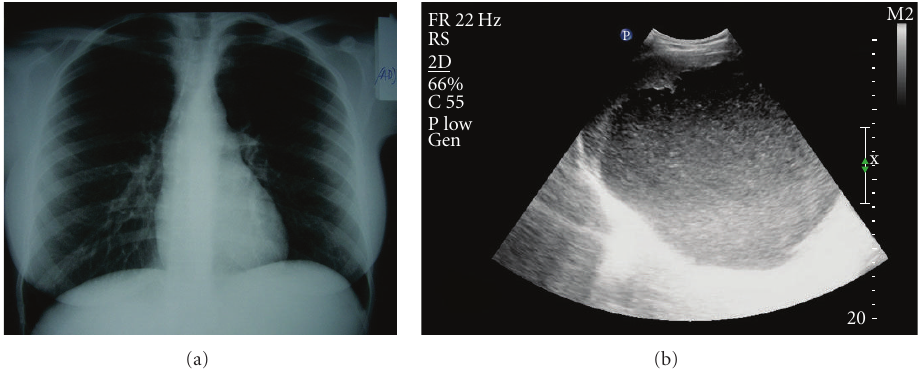
Figure 1: (a, b) Plain chest X-ray showing the elevation of the left hemidiaphragm (a). Abdominal ultrasound (US) showing a large, round hypoechoic lesion with internal echoes and regular thin wall surrounded by a peripheral rim of splenic tissue